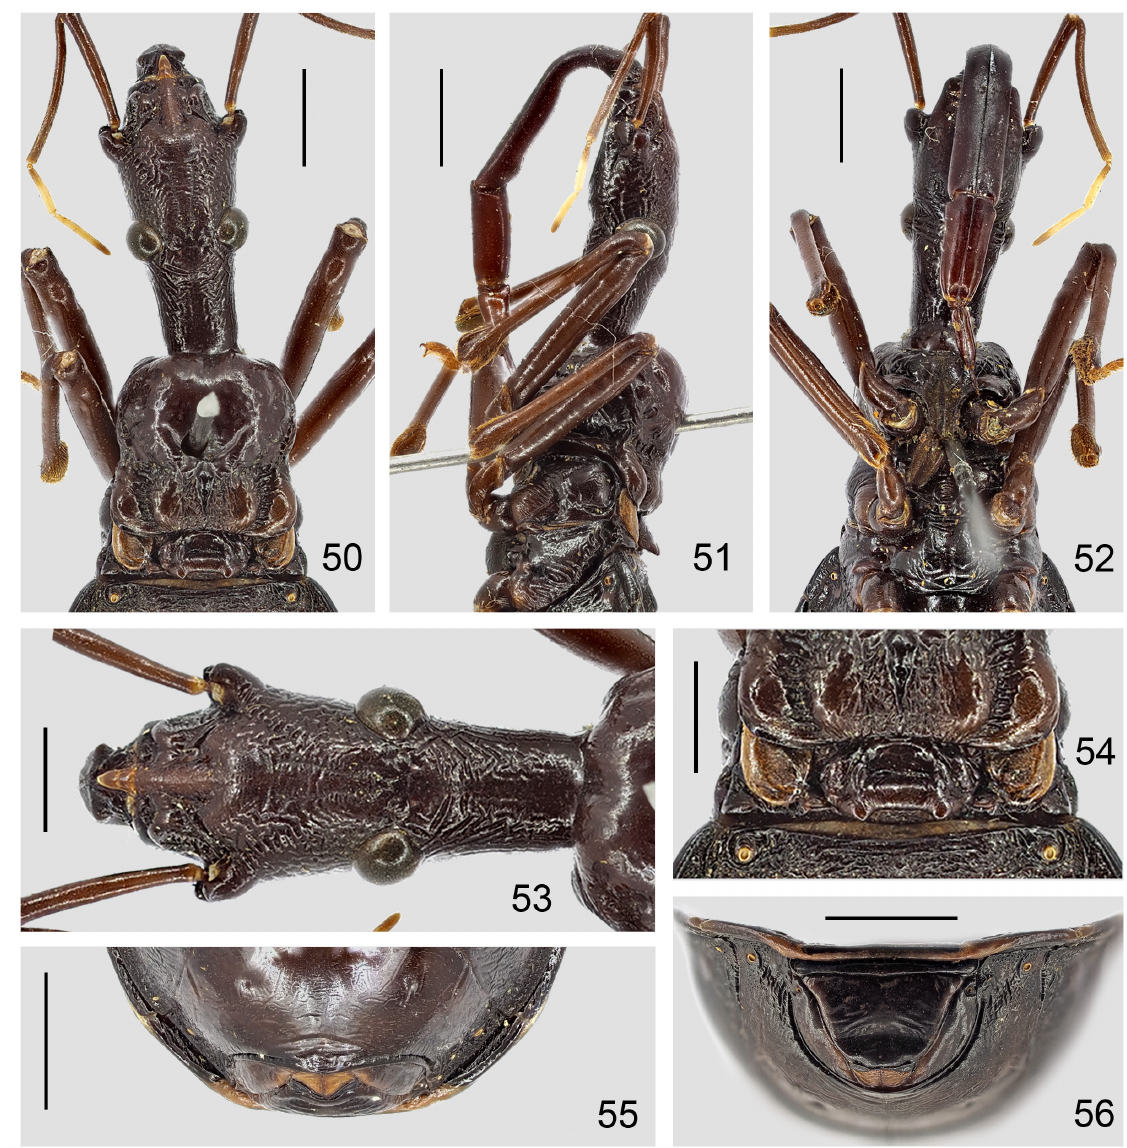
Figs 50–56. Xenorhyncocoris princeps Miller, 1949, holotype, ♀ (NHMUK 013587631). 50 . Anterior part of body, dorsal view. 51 . Same, lateral view. 52 . Same, ventral view. 53 . Head, dorsal view. 54 . Scutellum, dorsal view. 55 . Posterior part of abdomen, ventral view. 56 . Same, caudal view. Scale bars: 50–52, 55–56 = 3.00 mm; 53–54 = 2.00